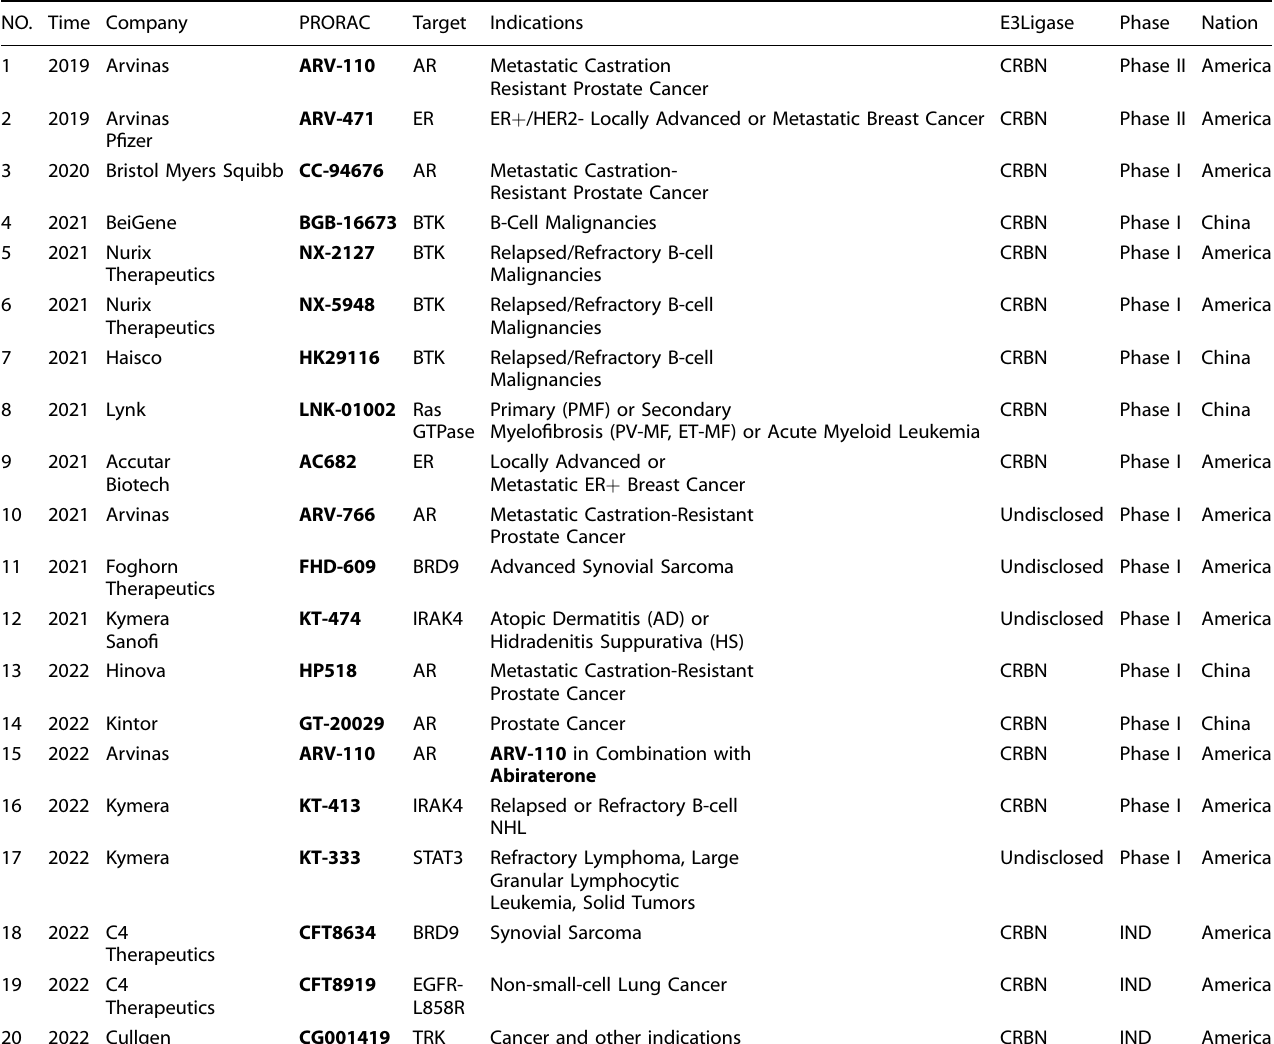
Table 7. The summary of protein-degradation drug candidates based on PROTAC technology in the global clinical and IND stages (data source: https://clinicaltrials.gov updated: 3/20/2022) NO. Time